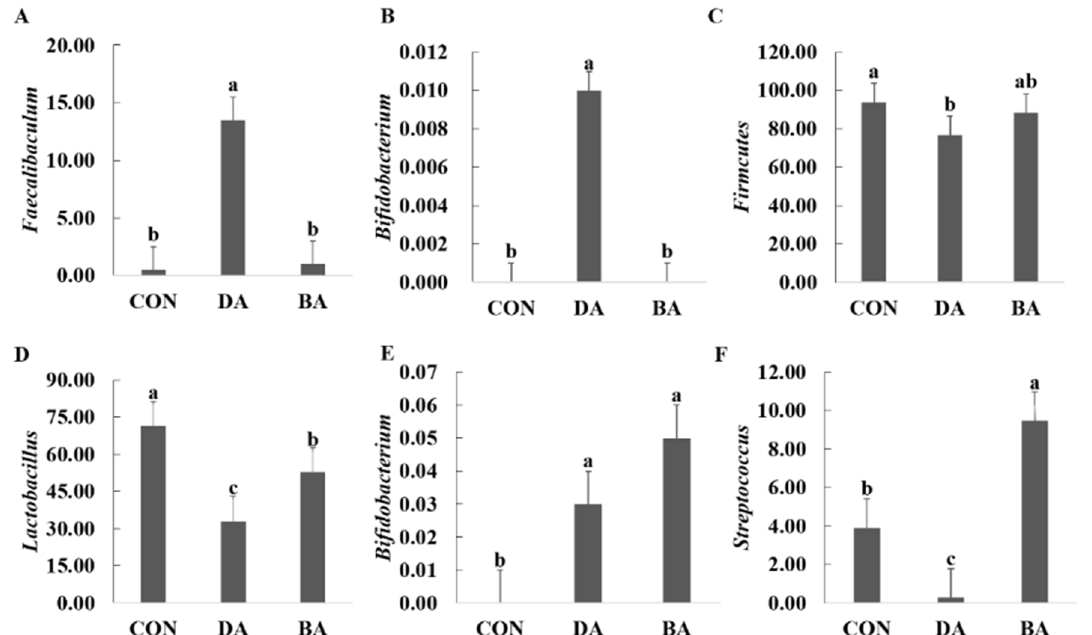
Figure 6. Effects of sodium decanoate and sodium butyrate on microflora structure in the ileum and colon of C57BL/6 mice at phylum and genus levels (Exp. 2). ( A ) An abundance of Faecalibaculum in the colon, %. ( B ) An abundance of Bifidobacterium in the colon, %. ( C ) An abundance of Firmcutes in the ileum, %. ( D ) An abundance of Lactobacillus in the ileum, %. ( E ) An abundance of Bifidobacterium in the ileum, %. ( F ) An abundance of Streptococcus in the ileum, %. A total of 36 mice with weaning age of 28 d were allocated into three dietary treatments randomly, which are control (CON), 5 g/kg sodium decanoate (DA), and 5 g/kg sodium butyrate (BA) diets. At the end, the intestinal digesta sample from each mouse was collected from the approximately middle positions in the ileum and colon to evaluate microbial community composition. Differential bacteria were analyzed using the R language. a,b,c Significant differences are indicated by different lowercase letters ( p < 0.05), n =